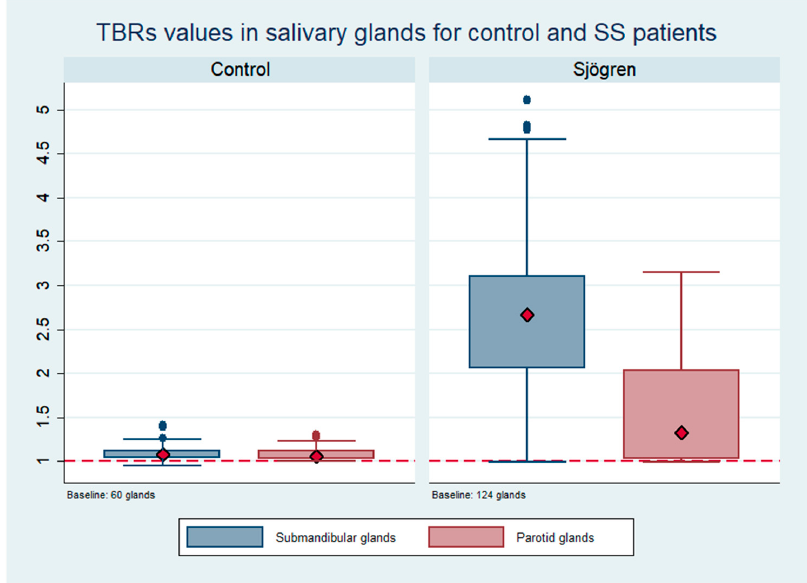
Figure 1. Target background ratio (TBR) in salivary glands of primary SS patients and control subjects.